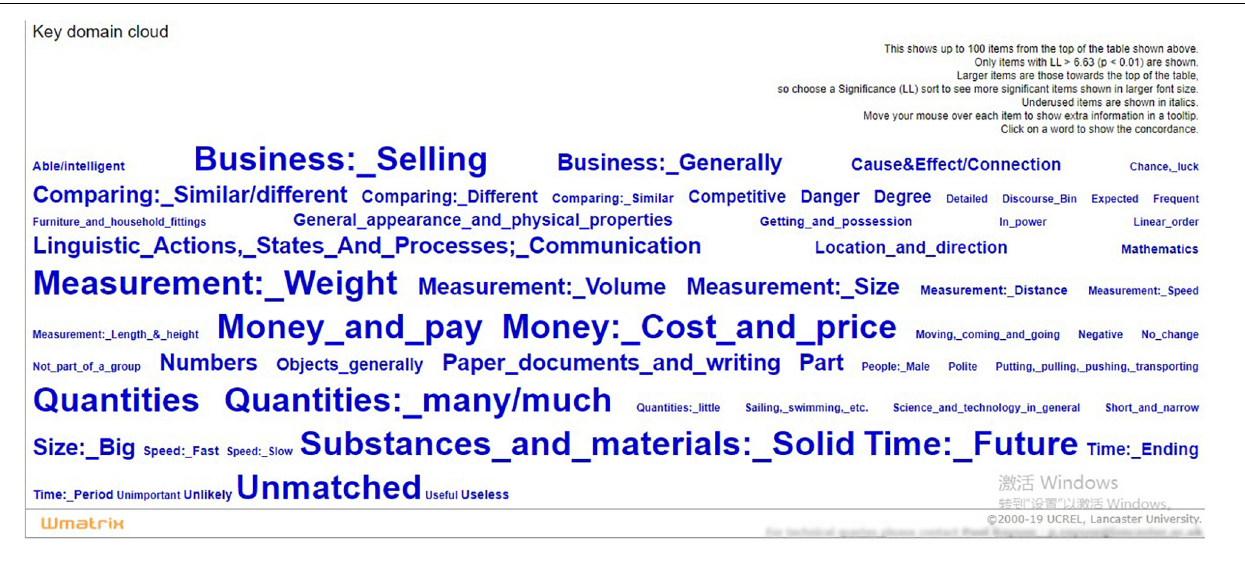
FIGURE 1 | Key semantic domain cloud of the annual report Chief Executive Officer (CEO)